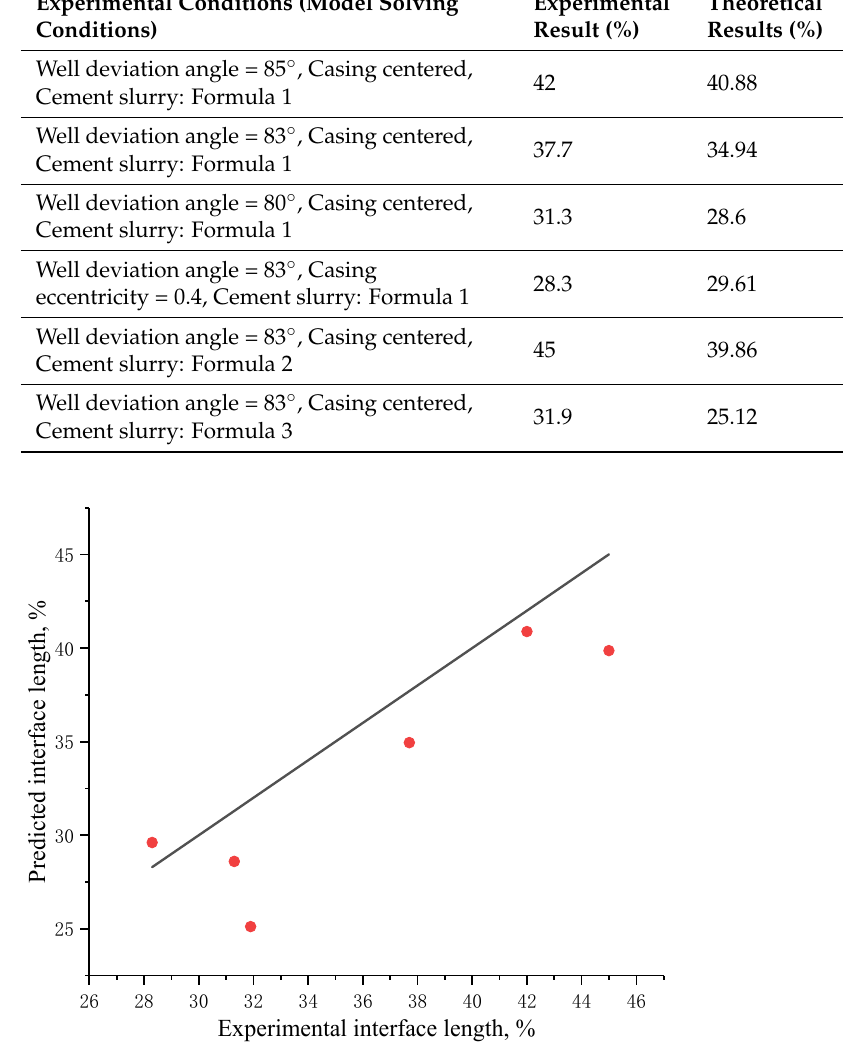
Figure 6. Experimental and predicted interface length.